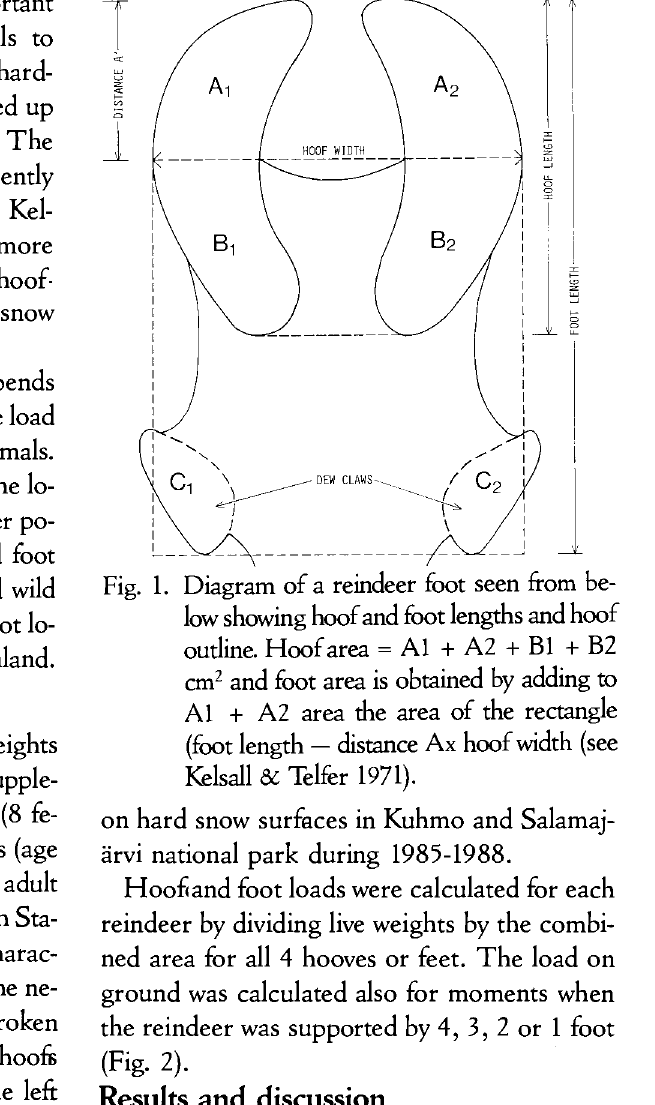
Fig. 1. Diagram of a reindeer foot seen from be low showing hoof and foot lengths and hoof outline. Hoof area = Al + A2 + Bl + B2 cm 2 and foot area is obtained by adding to Al + A2 area the area of the rectangle (foot length — distance Ax hoof width (see Kelsall & Telfer